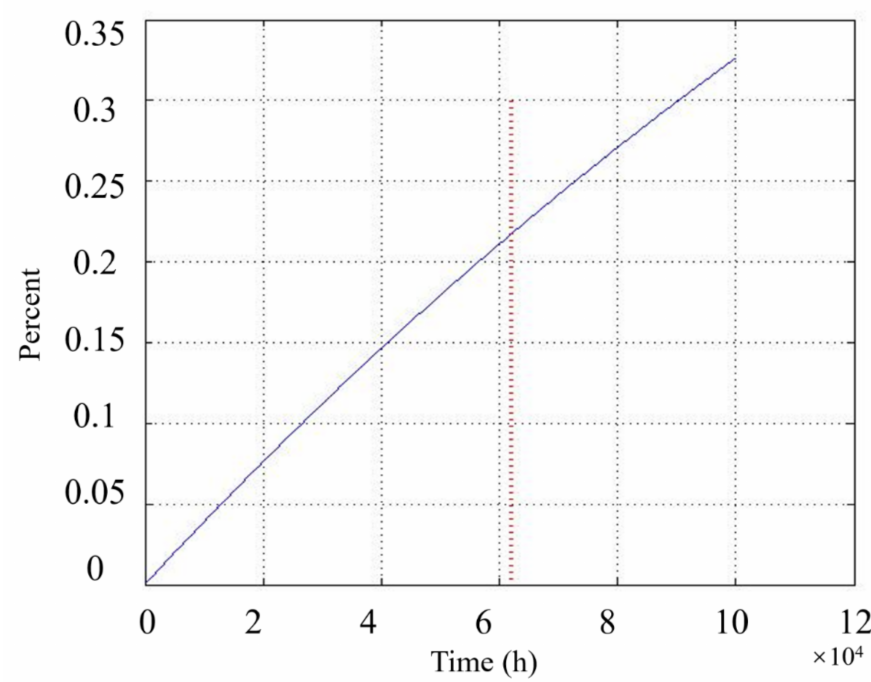
Figure 11. Capacitor failure probability distribution function considering thermal